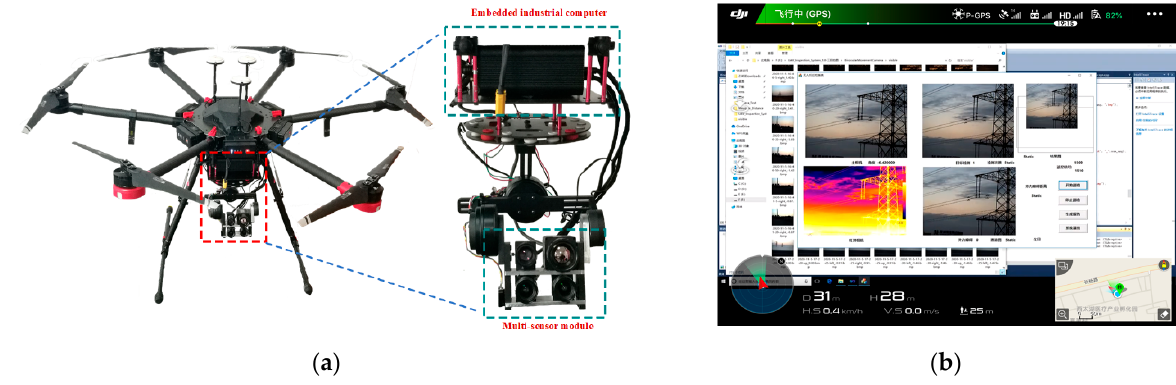
Figure 17. Multi-source sensor UAV inspection system: ( a ) hardware framework of the system; ( b ) interface of multi-source sensor information collaborative processing.